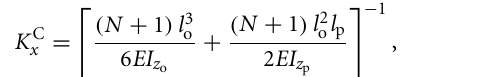
The stiffness equations in the x , y , and z axes for the serpentine cable are given by (31),